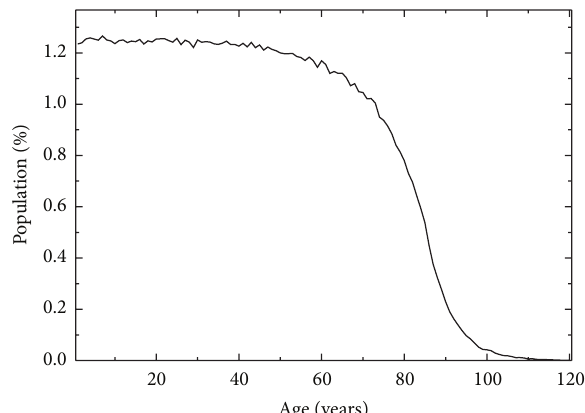
Figure 2: Percentage of persons with a given age in years obtained from the Foerster-McKendrick model after the warming-up period is